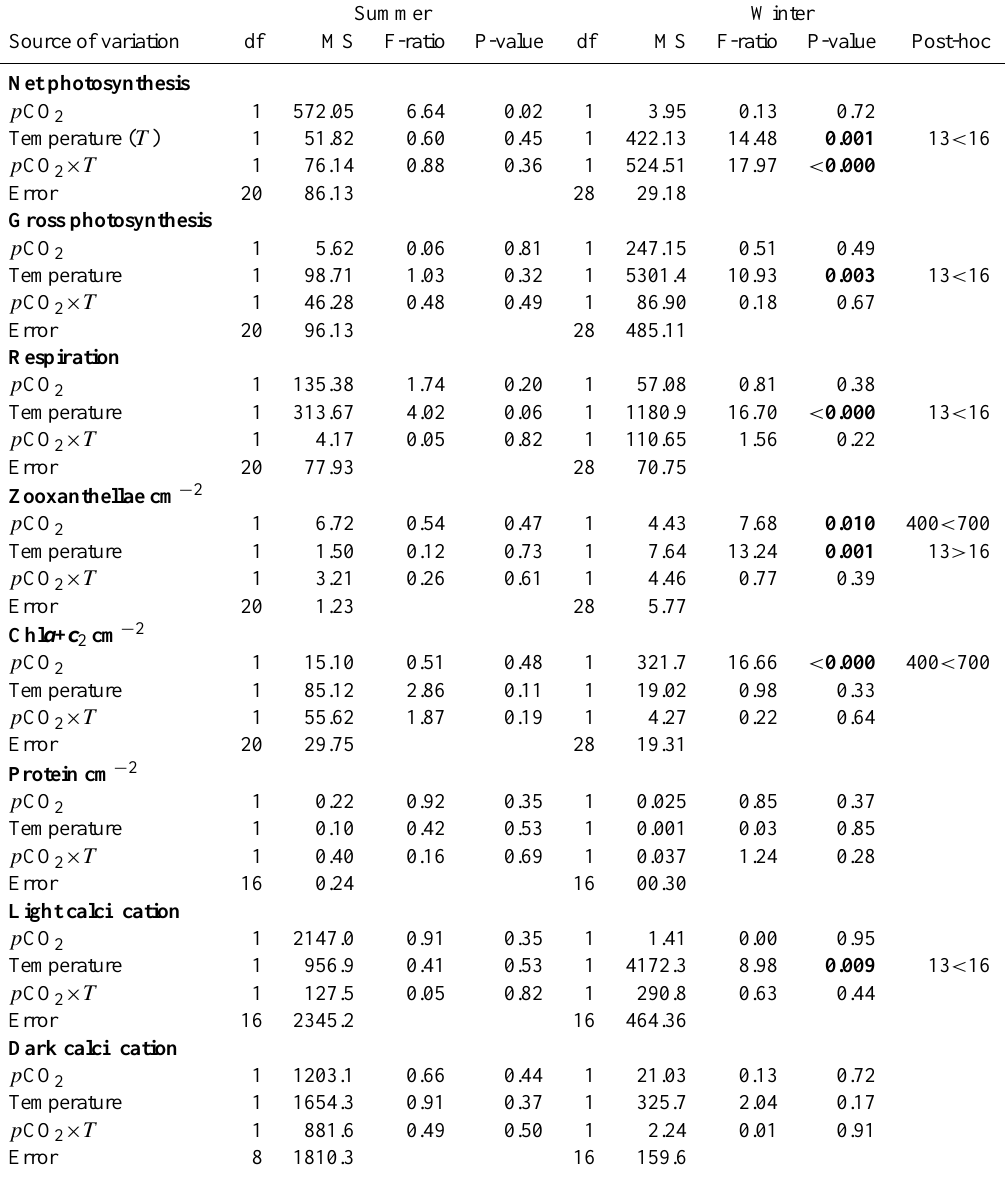
Table 2. Summary of two-way ANOVAs followed by Tukey honest significant difference post-hoc tests testing the effect of short-term incu- bation at two levels of p CO 2 (400 and 700µatm), and 2 temperature treatments ( T , T + 3 ◦ C) on Cladocora caespitosa main physiological parameters during summer and winter. Bold face numbers indicates P < 0 .